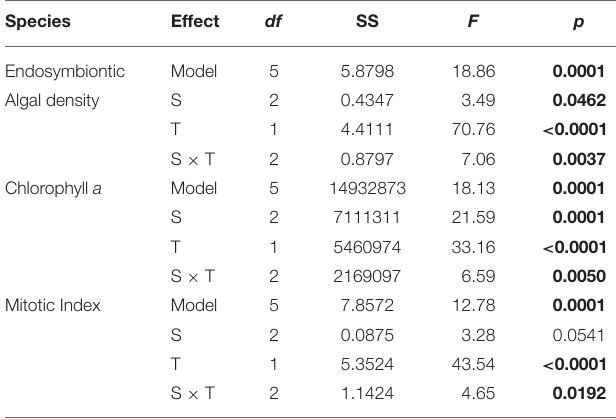
TABLE 1 | Results of three two-way ANOVAs testing for the effect of species (S), and temperature (T) on average chlorophyll a concentration, endosymbiotic algal density and mitotic index.